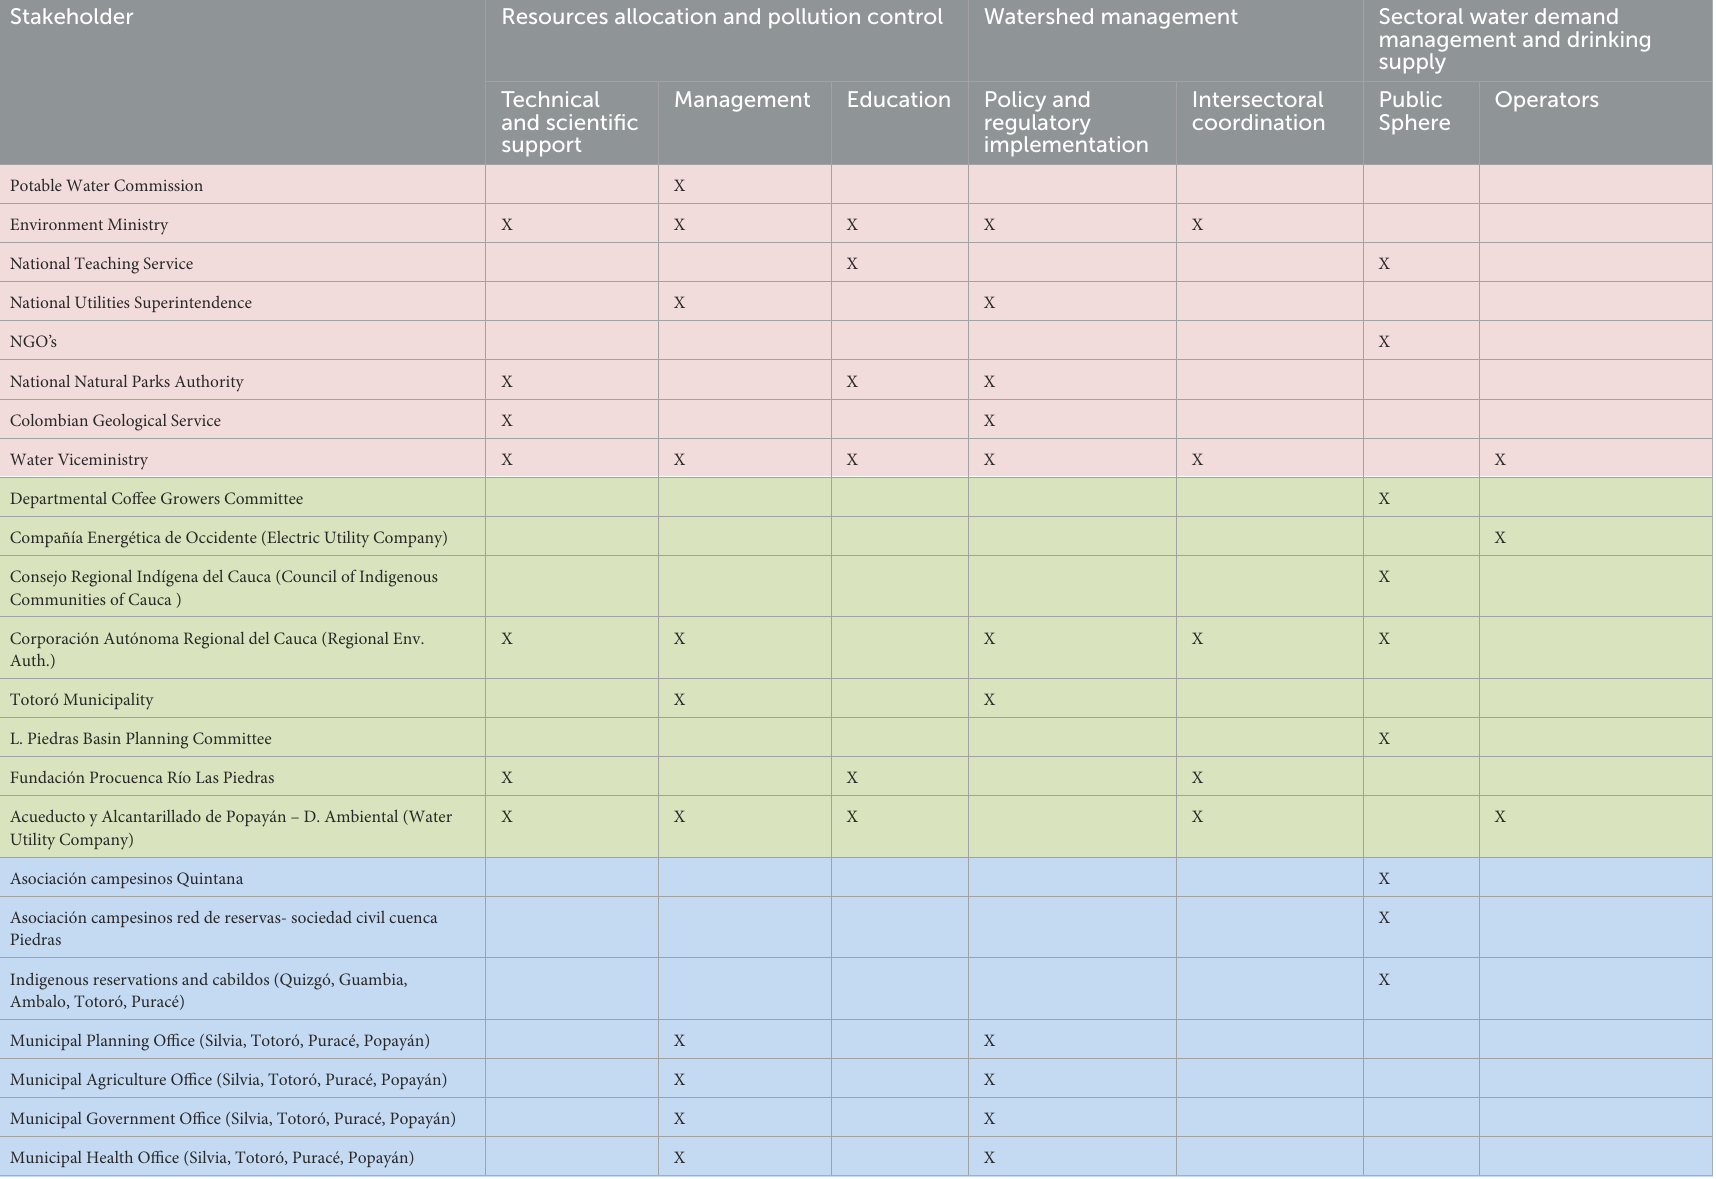
TABLE 3 Identified national, regional, and local actors in relation to water governance of the